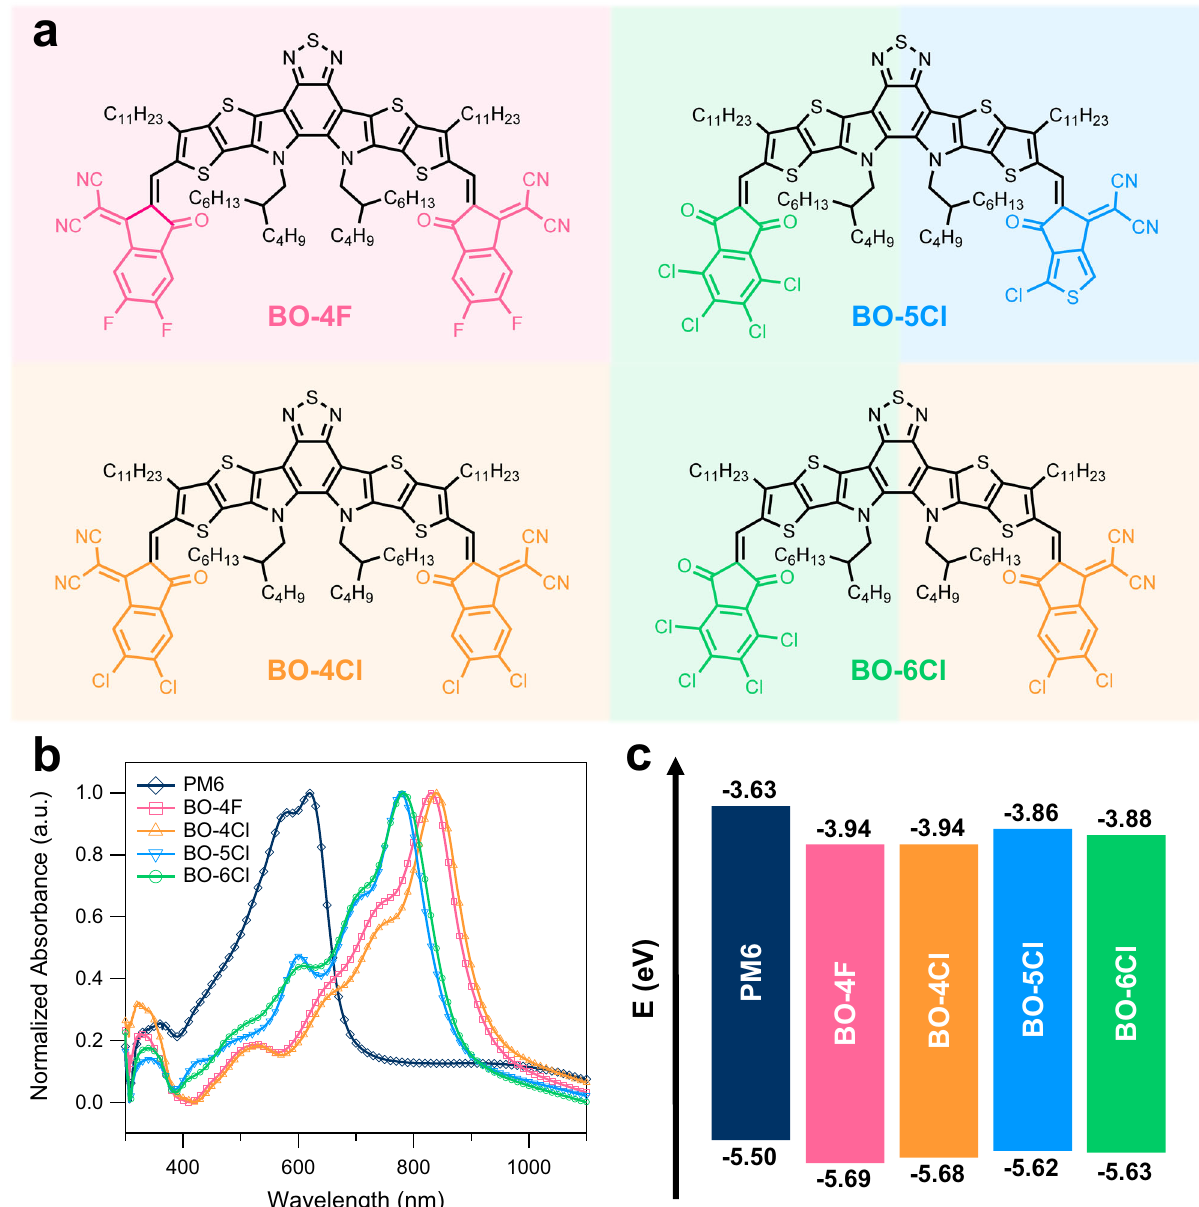
Fig. 1 Basic characteristics of the target acceptors. a Chemical structures of the four acceptors. b UV – vis absorption spectra of thin fi lms. c Energy-state diagram determined by cyclic